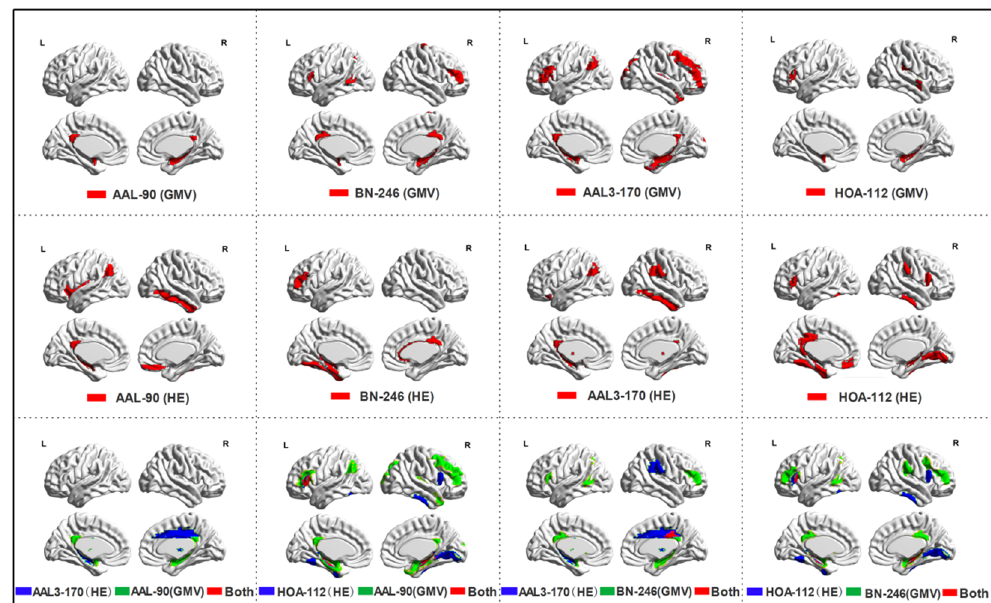
Figure 4. The most discriminative features in single-atlas or multi-atlas models.